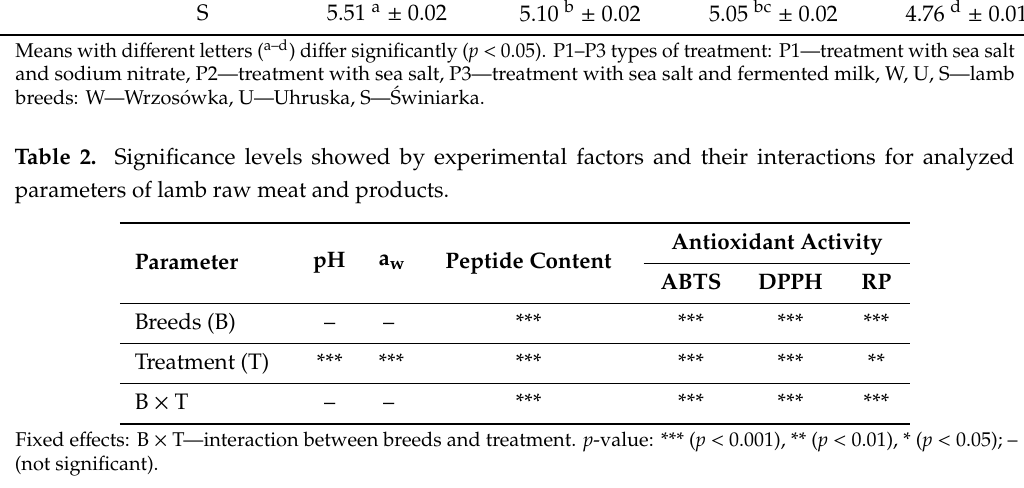
Antioxidant Activity